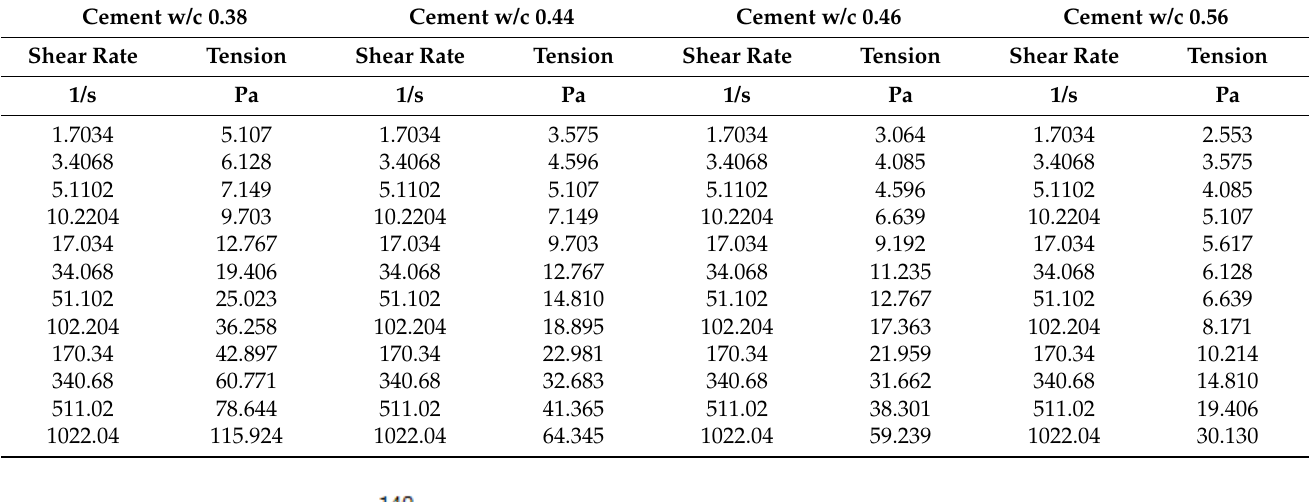
Table 2. Relations between shear stresses and shear rates obtained from laboratory tests on a Chan model 3500 viscometer (R1-B1, F1).